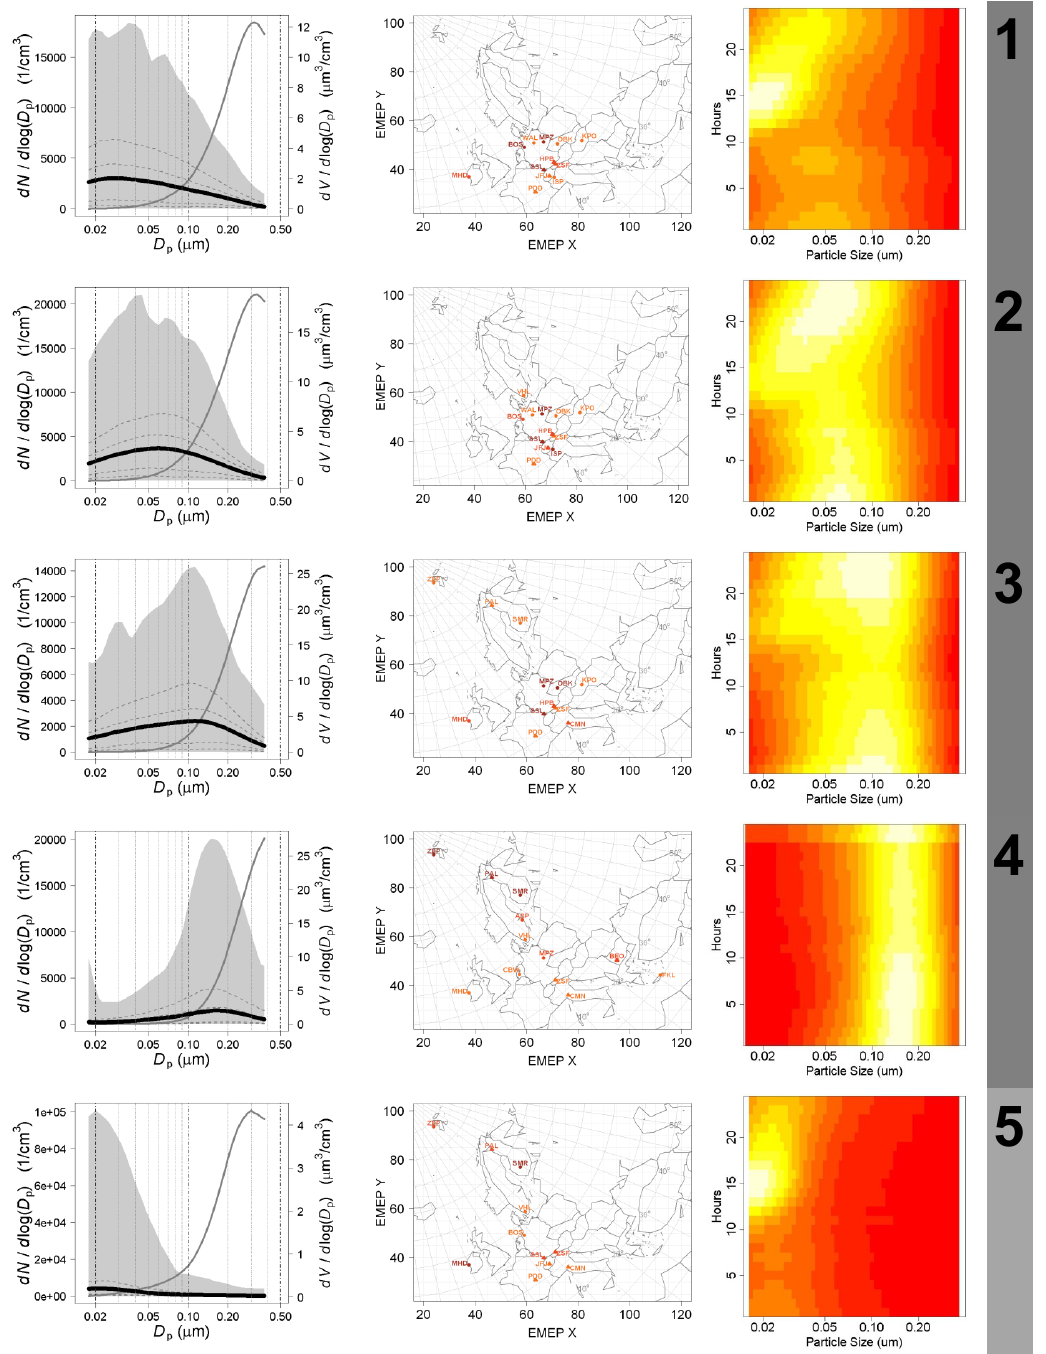
Fig. 4. Average clustered particle size distributions (Clusters 1–9 left hand panels) and the spatial distribution of each cluster (centre panels). The solid black line shows the average spectrum and the dashed lines show the 10th, 25th, 75th and 90th percentile spectrum. The maximum and minimum spectra are traced out by the extremities of the shaded areas. The middle panels show where each of the clusters are most likely to be detected. When counting the spectrum types within the whole data set, the sites which collected above the 90th, 75th and 50th percentile were marked with a progressively lighter orange colour (see Fig. S5 for the frequency distributions). Circles denote boundary layer sites and triangles denote sites of relatively high altitude. The right-hand panel shows the colour maps plotted using the average day of hourly spectra for each of the clusters. (The shade from red-yellow-white represents a linear scale of dN / d log( D p ) between the minimum value of the 10th percentile spectrum and the maximum value of the 90th percentile spectrum shown for each